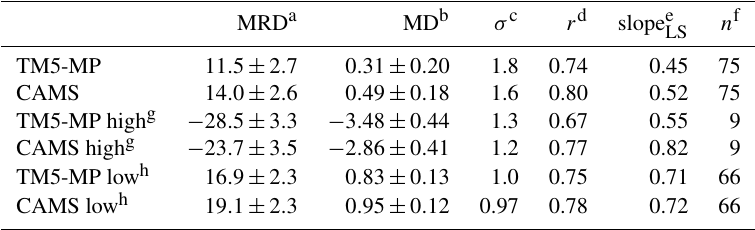
Table 2. Statistics of the comparisons between TROPOMI summed columns calculated using two different a priori NO 2 profiles (TM5-MP and CAMS regional) and Pandora total columns during 30 April to 30 September 2018. The uncertainties are given as standard errors of the mean.